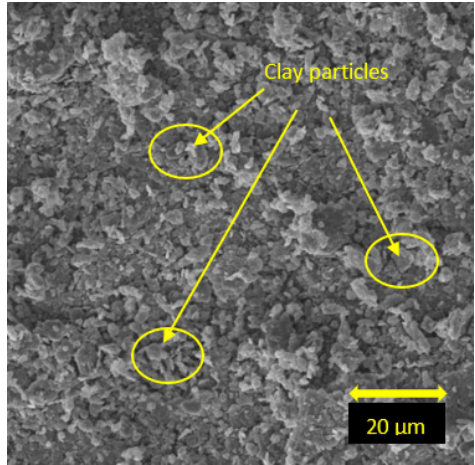
Figure 14. SEM images of clay (control sample).